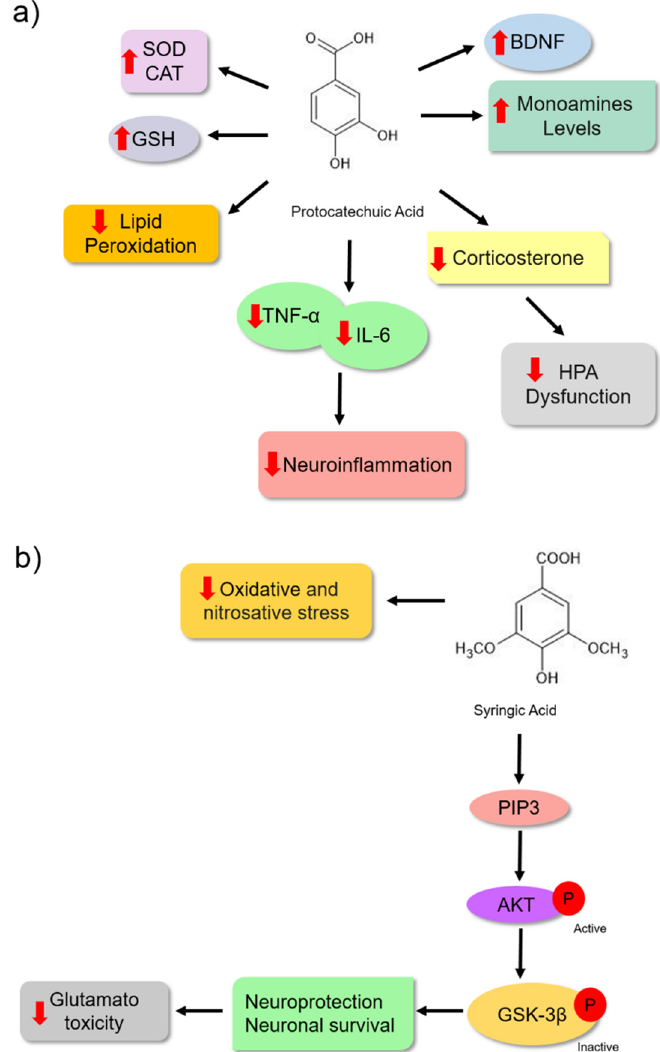
Figure 6. Possible mechanisms of action for protocatechuic acid ( a ) and syringic acid ( b ) as antidepressants based on preclinical trials. ( a ) Protocatechuic acid has been shown to have a depressant effect mainly through antioxidant mechanisms. It increases the activity of the enzymes catalase (CAT), superoxide dismutase (SOD), and the amount of glutathione reductase (GSH). Then, it can prevent lipid peroxidation and inhibit oxidative stress. The antidepressant effect of the bioactive molecule is possible because of its potential to reduce neuroinflammation by inhibiting the deregulation of the hypothalamic–pituitary–adrenal (HPA) axis, increasing brain monoamines, and promoting an increase in BDNF levels. ( b ) Syringic acid promotes antidepressant effect by its antioxidant potential, reducing oxidative stress and nitrosative stress. Another important antidepressant mechanism of this molecule may be associated with glutamatergic excitotoxicity inhibition by PI3K/Akt/GSK-3 β neuronal survival pathway activation. Arrows in red (up) indicate increased levels and (down) reduced levels. The solid black arrow indicates stimulation, and the dashed black arrow indicates the possibility of activation (mechanism not directly evaluated in the study). The chemical structures were drawn using ChemSketch freeware, version 14.0 from ACD/Labs.